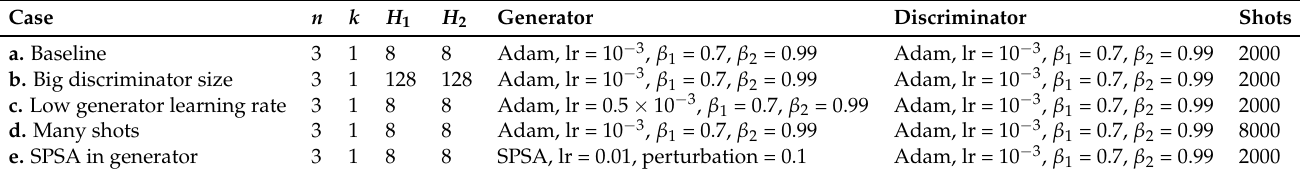
Table 2. Test cases used in Figure 2. More details can be found in Table